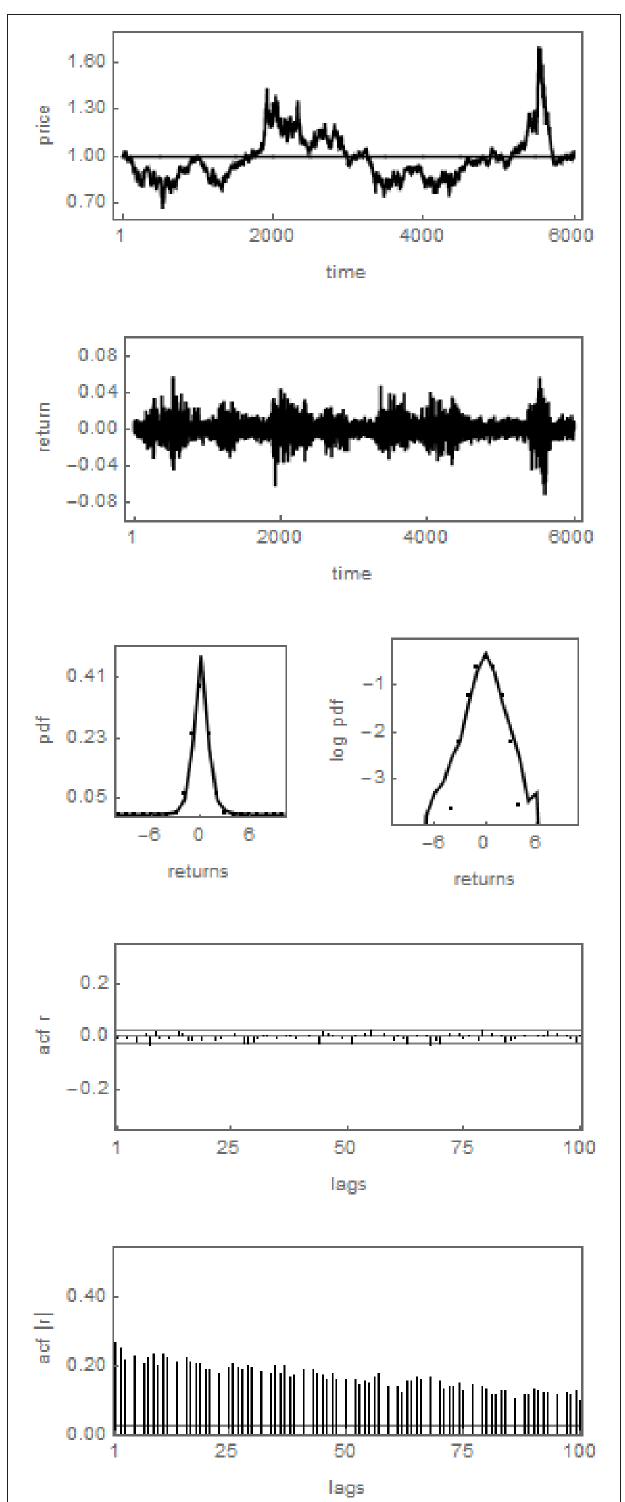
FIGURE 6 | The panels show from top to bottom the evolution of prices, the corresponding returns, the distribution of returns (left panel: usual representation; right panel: log-linear representation), the autocorrelation function of returns and the autocorrelation function of absolute returns, respectively.